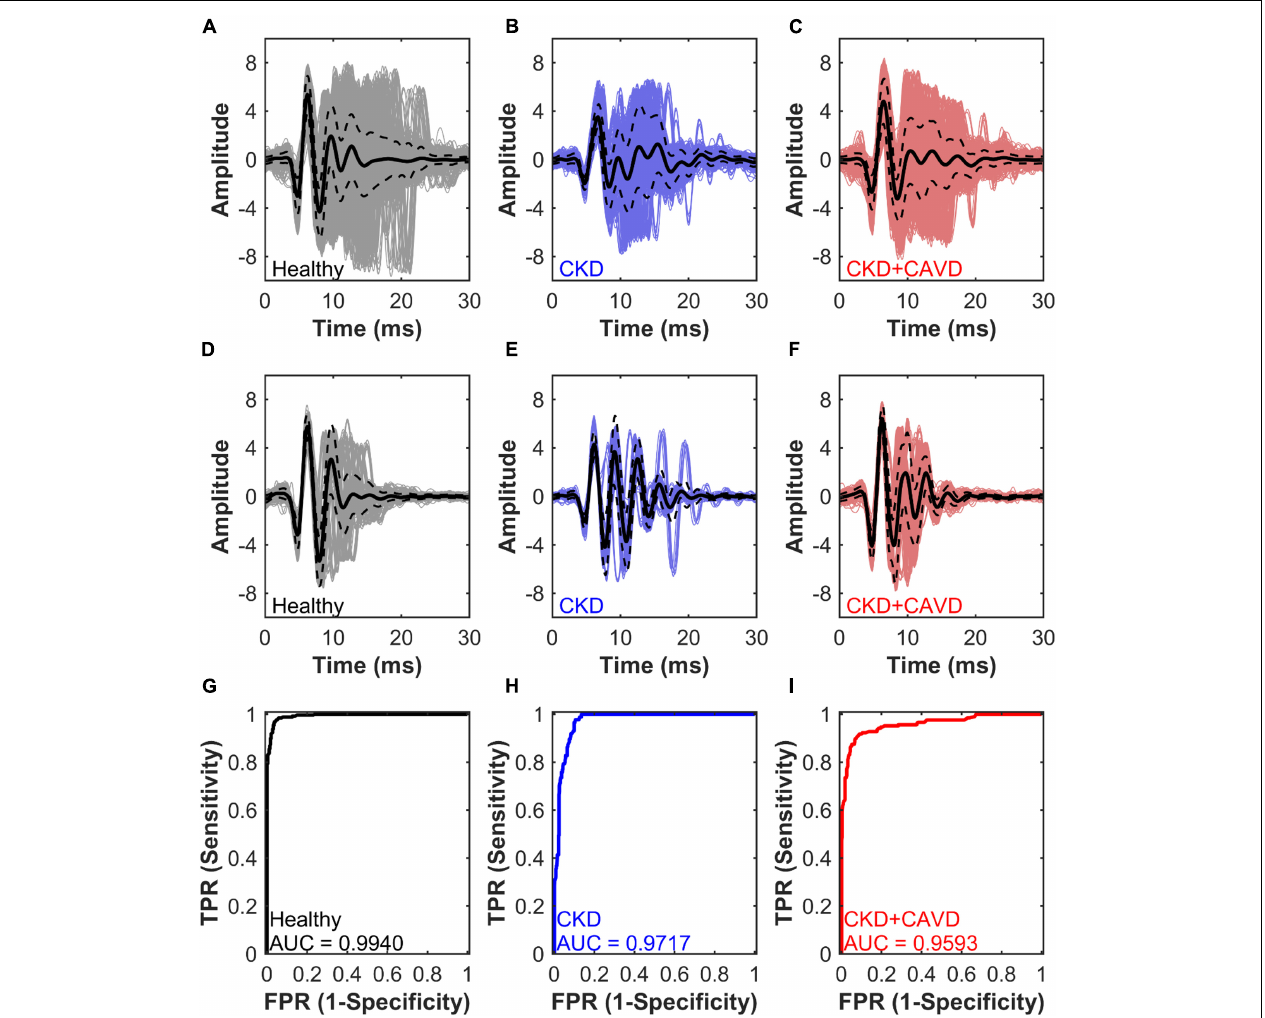
FIGURE 7 | Algorithm performance for S2 sound classification. Average waveforms and algorithm performance of the final algorithm. Performance is measured by AUC, area under the receiver operating characteristic curve for testing set S2 sound classification. (A–C) Healthy, CKD, and CKD + CAVD training set average S2